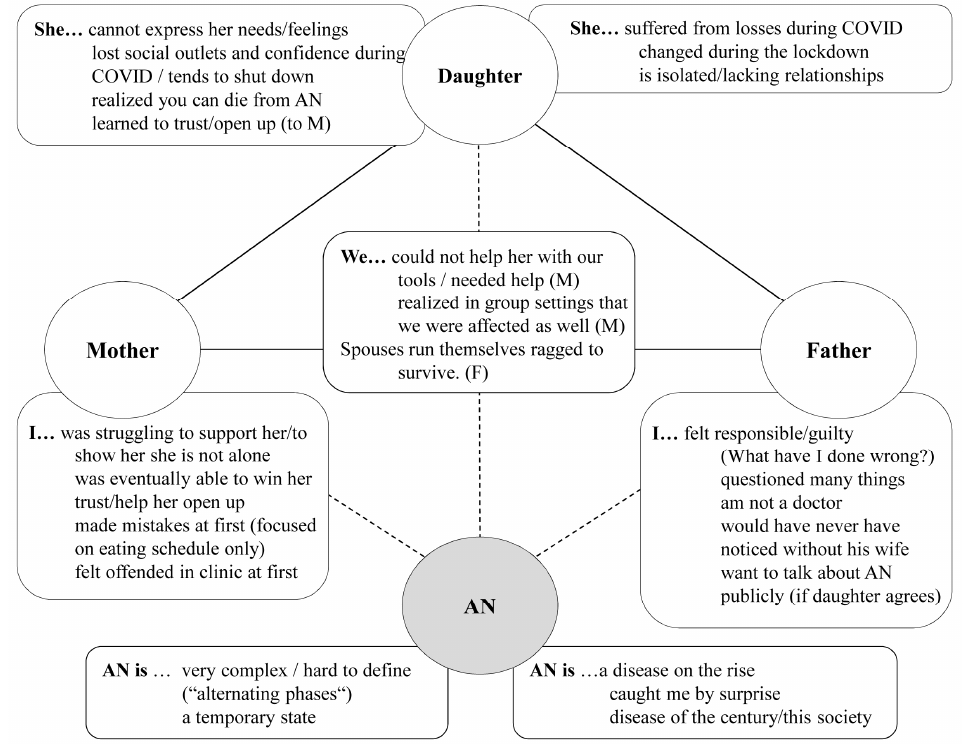
Figure 1. First parental dyad: overview of positions claimed for oneself (mother/father/dyad) and assigned to the daughter, and anorexia nervosa (AN) (M = mother; F = father) .